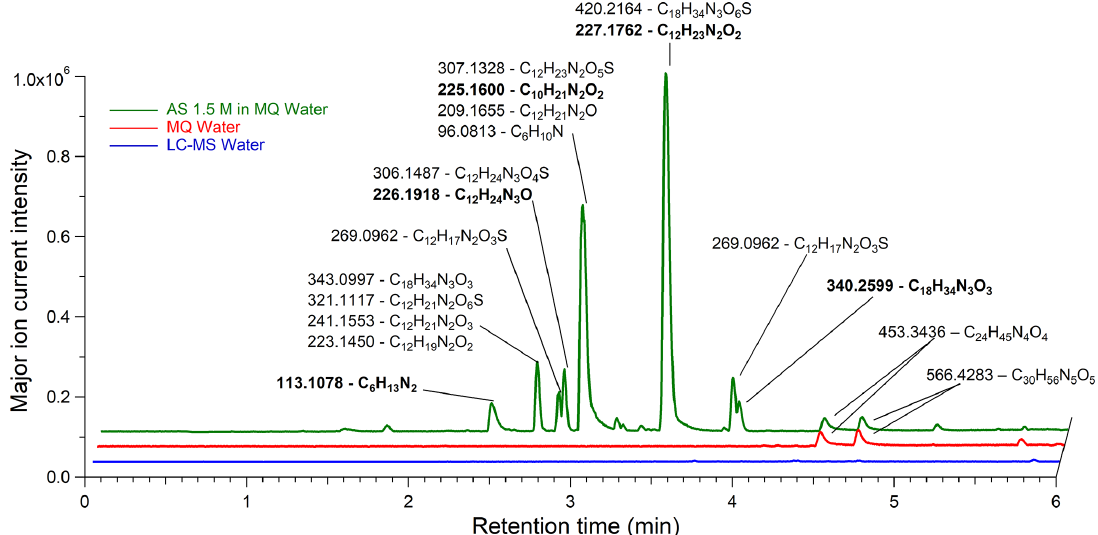
Figure 7. LC/ESI + –MS base peak chromatogram of Milli-Q water, Fisher water, and AS (99.5%) solution of 1.5M (EXP C1) with corre- sponding major ion masses associated with raw formulas. The bold ion masses and proposed raw formula were studied in MS–MS (EXP C9). Ions displayed in boldface were detected in their [M − H] − form in LC/ESI − –MS (in EXP